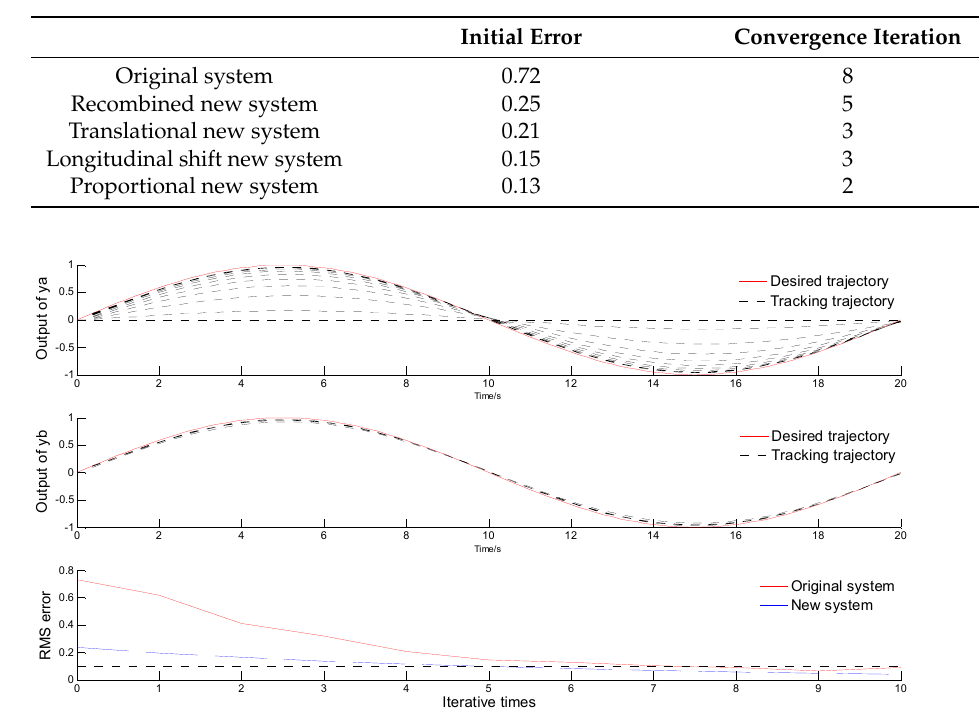
Figure 9. PD - ILC/Sine Curve of Recombined Experience Transform.